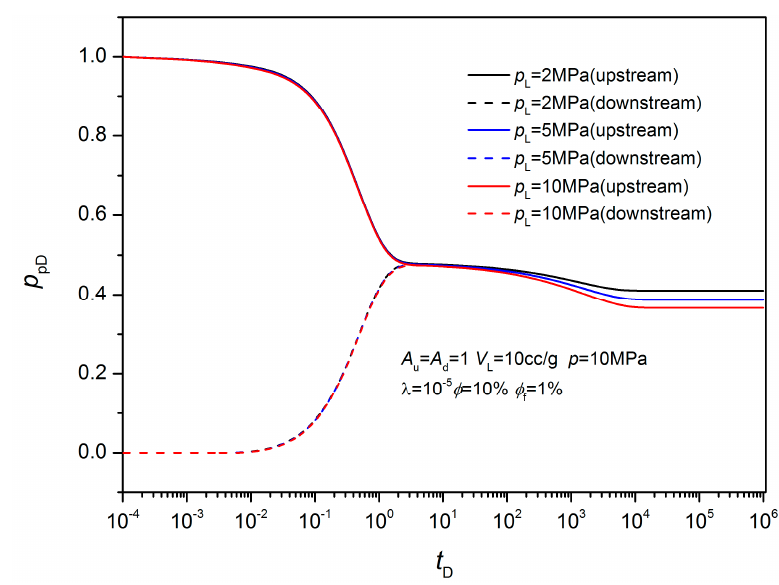
Energies 2019 , 12 , x FOR PEER REVIEW Figure 8. The influence of the Langmuir pressures on the pseudo-pressure the non-equilibrium sorption.